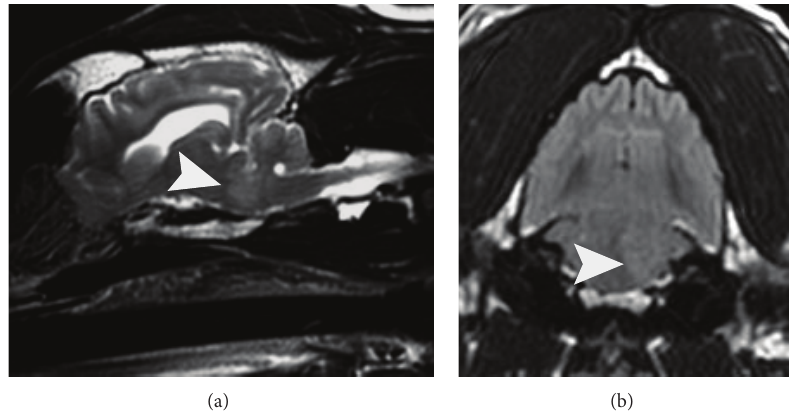
Figure 1: (a) T2-weighted sagittal and (b) FLAIR transverse pulse sequences of the brain, at the level of the pons. There is a broadbased ill-defined homogeneous hyperintense lesion (arrowhead) along the sphenoid bone, encompassing approximately fifty percent of the left side of the pons and extending dorsal to the fourth ventricle, which appears slightly displaced to the right.